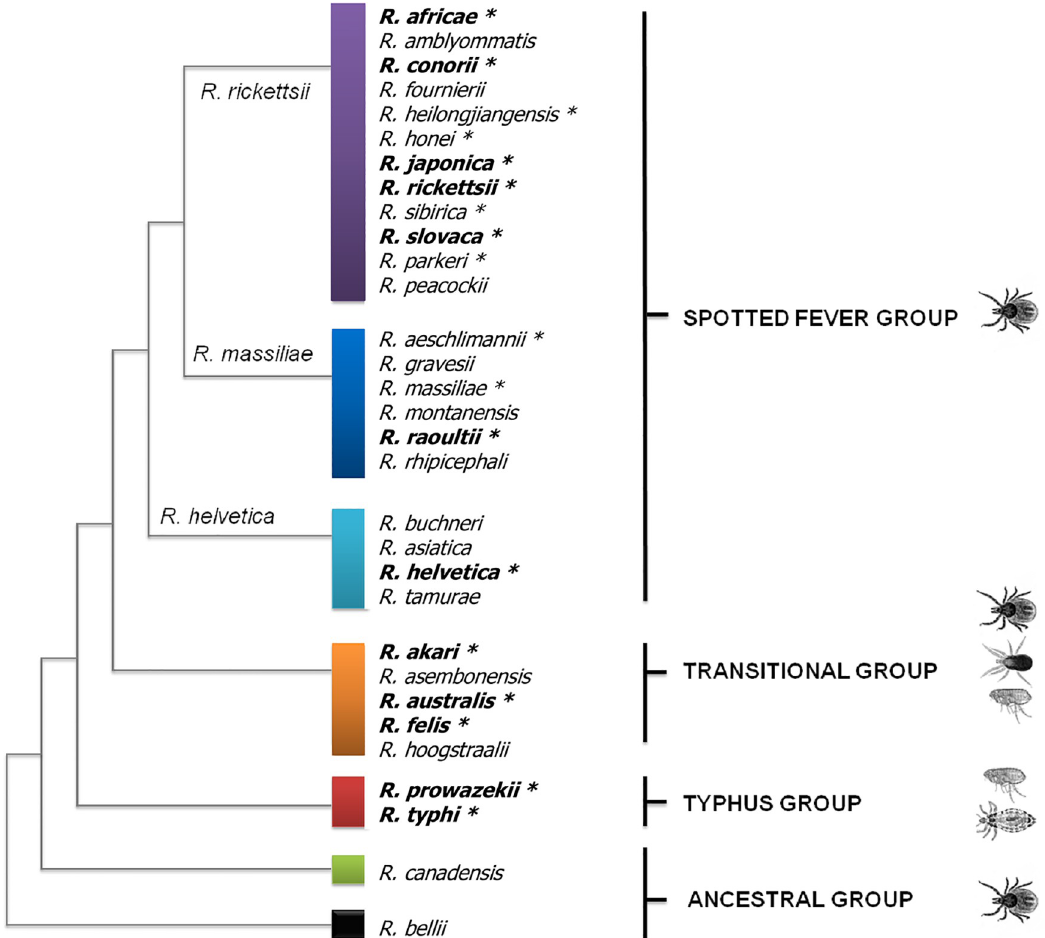
Fig 1. Phylogenetic tree of Rickettsia species inferred from the comparison of concatenated sequences from the gltA and sca 4 genes. Rickettsia species are distributed into 4 groups: SFG, TRG, TG, and AG. SFG rickettsiae are mostly associated with ticks; TG rickettsiae with human body lice ( R . prowazekii ) and rat fleas ( R . typhi ); TRG rickettsiae with ticks, cat fleas, or mites; and AG rickettsiae with ticks. Asterisks mark pathogenic species, and bold letters indicate species causing CNS infections. AG, ancestral group; CNS, central nervous system; SFG, spotted fever group; TG, typhus group; TRG, transitional group.